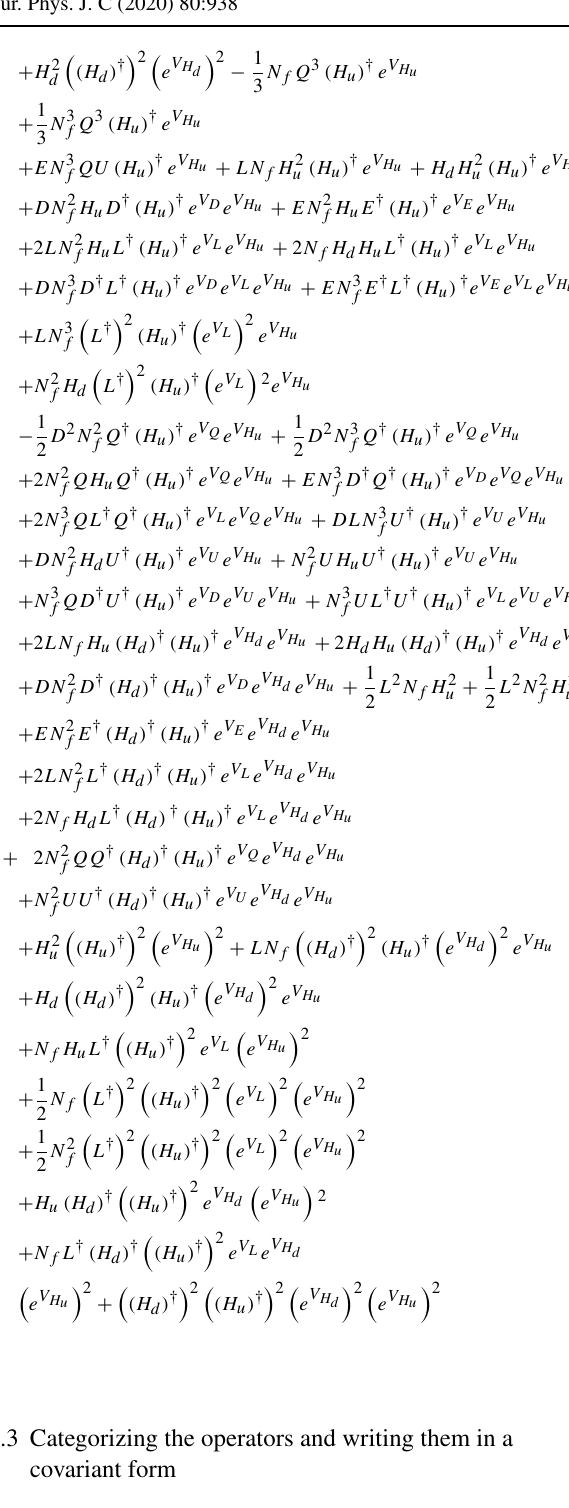
To convert the GrIP output into a covariant form, we employ the translation between symbols as outlined in Table 21. The correspondence between the Hilbert Series output generated by GrIP and their covariant forms is shown in Table